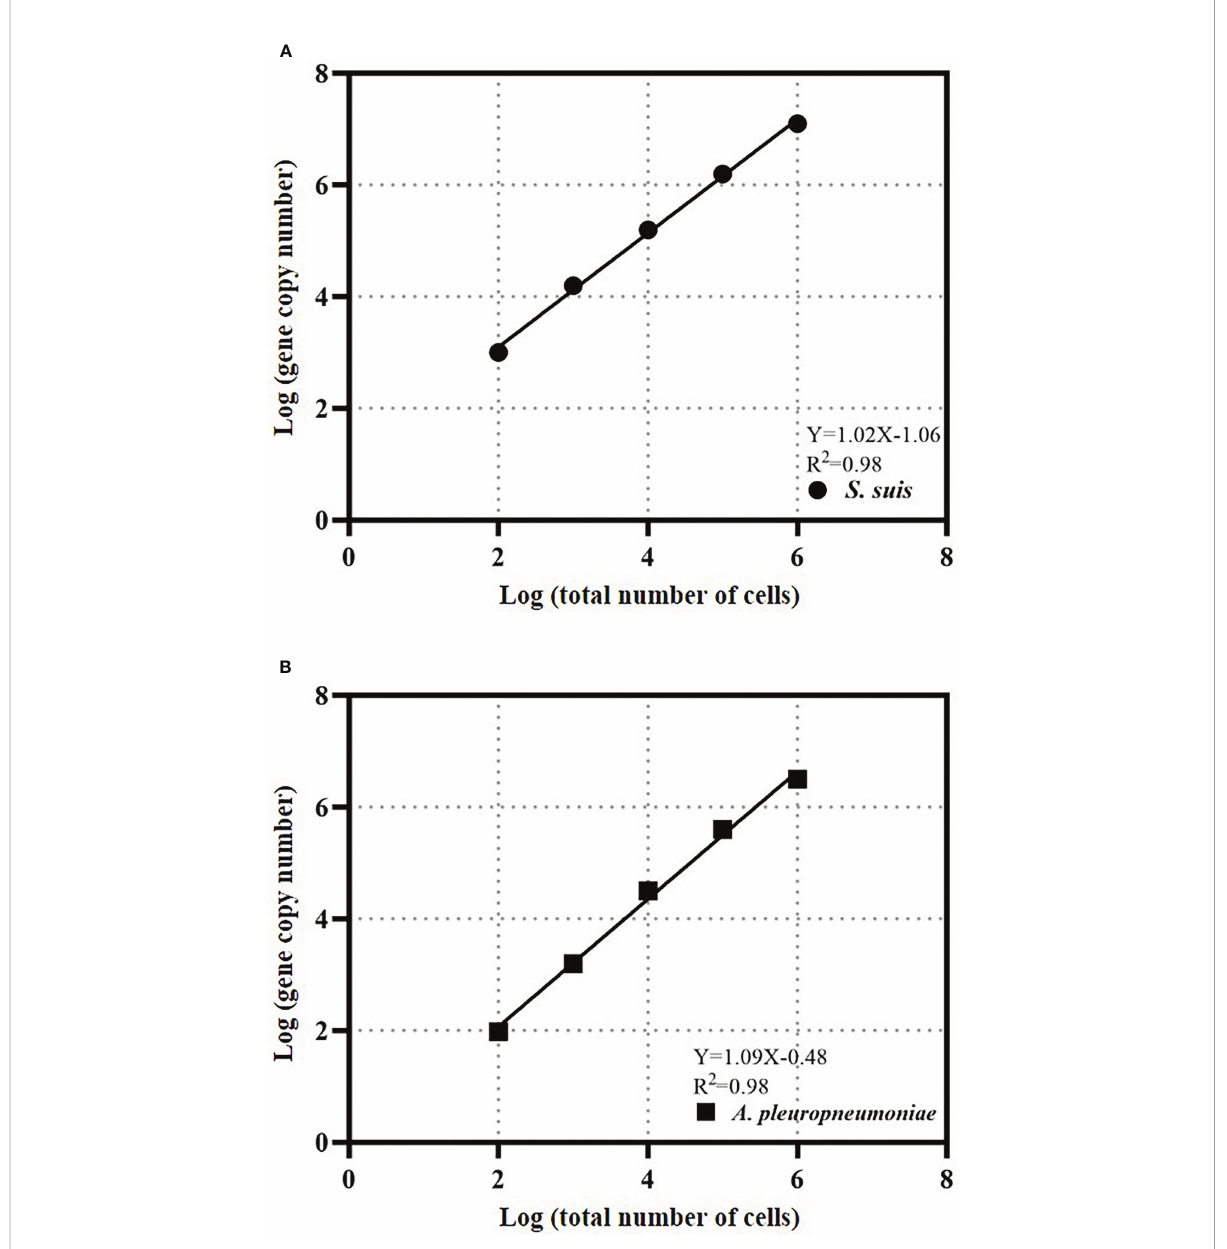
FIGURE 4 TaqMan real-time PCR estimates gene copy abundance and bacterial abundance of S. suis (A) or A. pleuropneumoniae (B) . The data is expressed as an average with 95% con fi dence interval band (n =